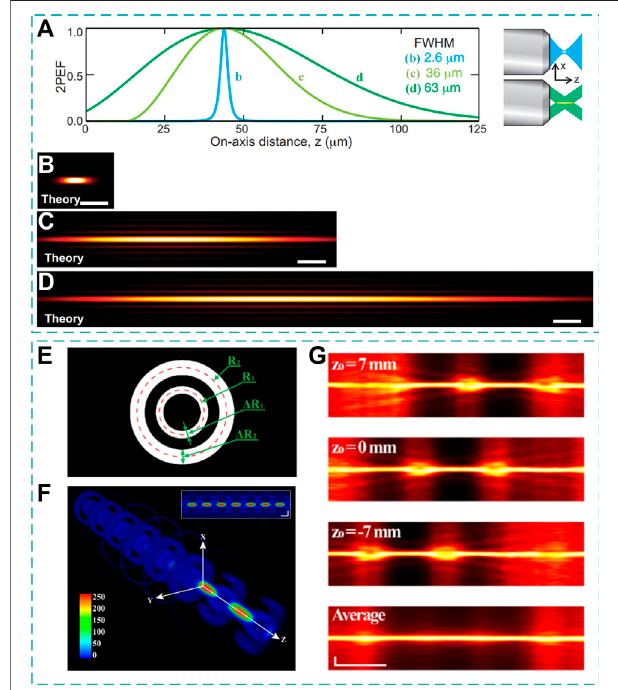
FIGURE 15 | (A – D) Longitudinal PSFs of Gaussian and Bessel beams [133]. (A) Two-photon fl uorescence along the longitudinal axis for an extended DOF setup (green) in contrast to a conventional setup (blue) with identical transverse resolution. (B) Theoretical PSF in the longitudinal plane with a standard DOF setup (Gaussian beam width (cid:2) 2.7 mm). (C,D) TheoreticalPSFwithextended DOF,wheretheincidentGaussianbeamwidth on the axicon is (C) 0.27 mm and (D) 0.47 mm. Scale bars, 5 μ m. (E) Illustrationofthedouble-ringphase pattern on SLM,with twoconcentric rings of fi nite width Δ R 1 and Δ R 2 [23]. The dashed circles demonstrate the average radii of the ring. (F) Perspective view of a 3D double-ring phase beam. Inset shows the side-view of the beam. Scale bars: 400 nm. (G) Side-view pro fi les of positively translated ( z 0 (cid:2) 7 mm), original ( z 0 (cid:2) 0 mm), negatively translated ( z 0 (cid:2) − 7 mm) double-ring PSFs, and the average of all the three PSFs. Reproduced from OSA [23,